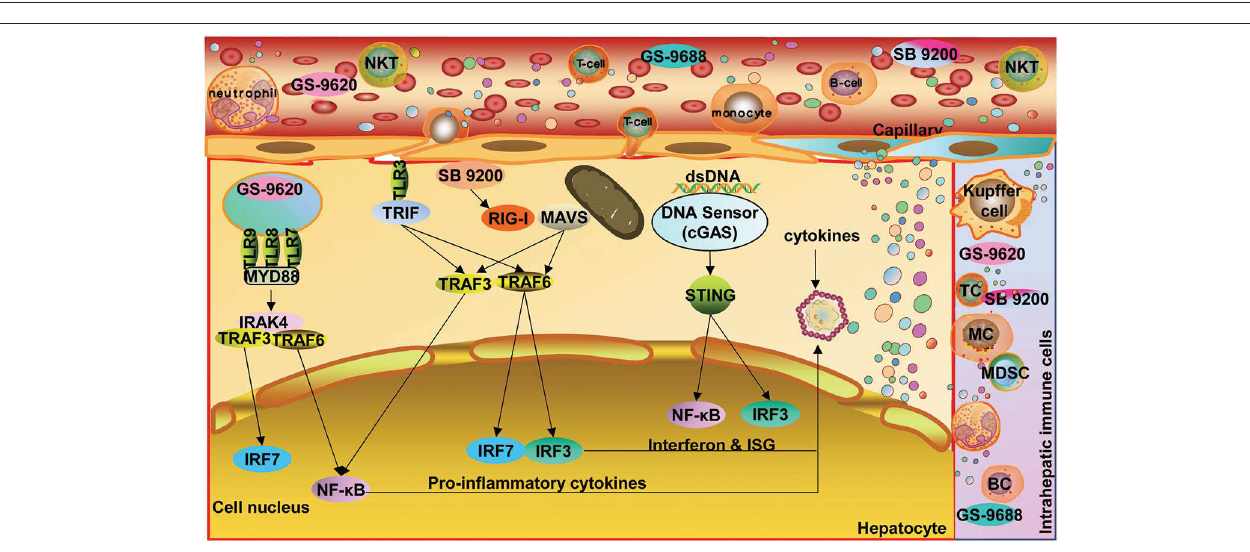
FIGURE 2 | Options for enhancing innate immunity and establish an antiviral state. Oral, intranasal, or subcutaneous application of agonists of PARs, including TLRs, RIG-I, and STING, activates host immune cells and hepatic parenchymal and non-parenchymal cells, leading to the production of IFN and proinflammatory cytokines as well as ISG expression. TLR, toll-like receptor; RIG-I, retinoic acid-inducible gene 1; STING, stimulator of interferon genes; NF- κ B, nuclear factor kappa-B; ISG, interferon-stimulated gene; cGAS, cyclic GMP-AMP synthetase. Dots in various colors indicate different cytokines. STING expression in hepatocytes remains